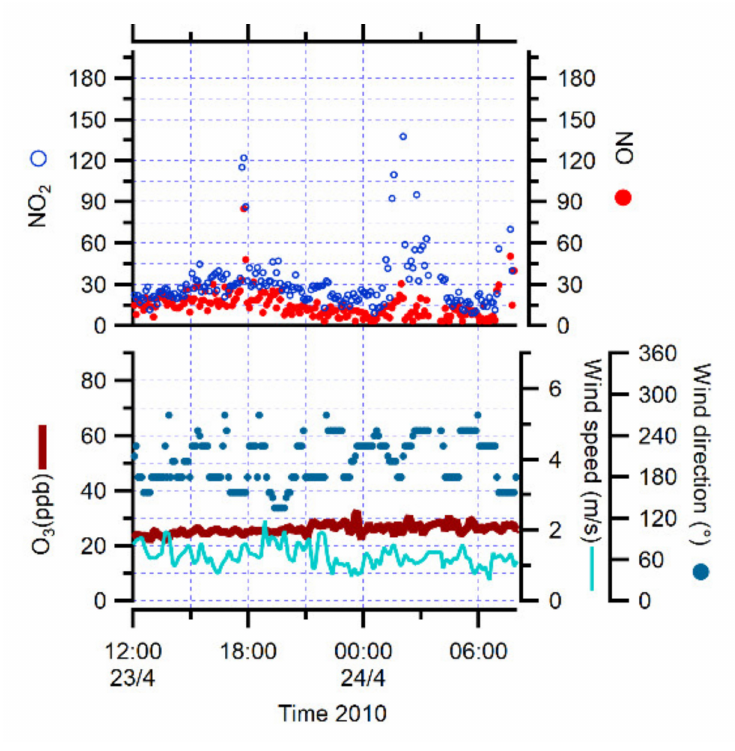
Figure 1. NO, NO 2 , O 3 concentrations, wind speed and direction during the regional pollution episode on 24 April 2010.